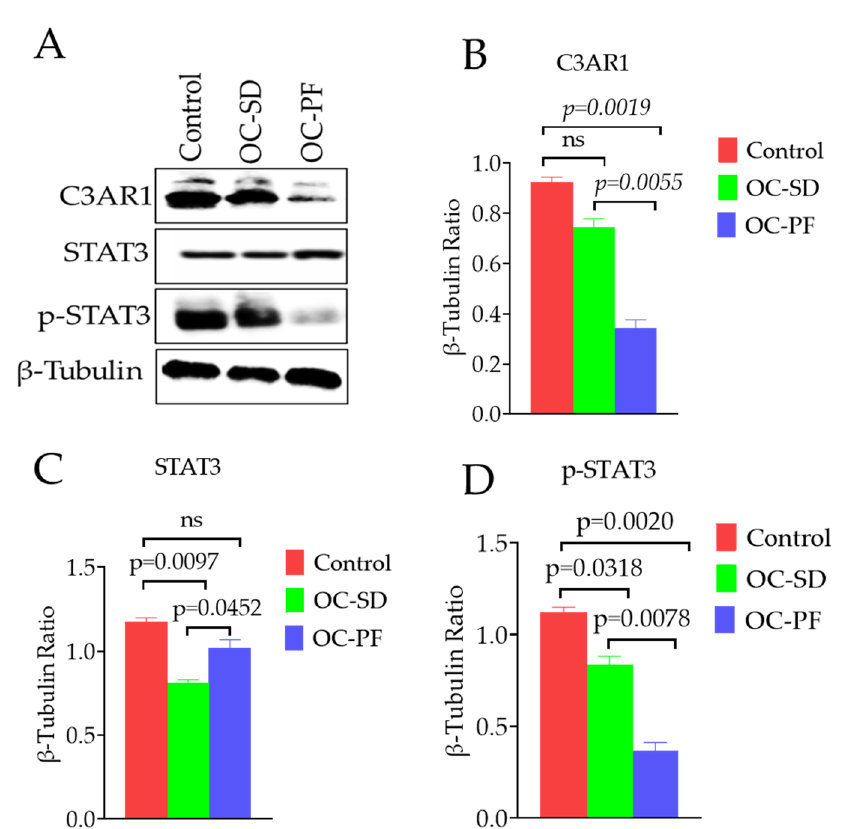
Figure 7. OC-PF and OC-SD treatment effects on the expression level of C3AR1, total and activated downstream target STAT3 in 5xFAD mouse brains. ( A ) Western blot showing the OC-PF and OC-SD treatments effect on the expression level of C3AR1, STAT3, and p-STAT3 in 5xFAD brain homogenates. ( B – D ) Scanning densitometric analysis of the blot for C3AR1 (F (2, 6) = 93.70, p < 0.05, STAT3 (F (2, 6) = 29.05, p < 0.05), and p-STAT3 (F (2, 6) = 88.00, p < 0.05), respectively. Scanning densitometry was executed for each blot, conducted in triplicate and the integrated optical density of each band was normalized with the corresponding density found for β -tubulin in the same blot. Data are presented as mean ± SEM. Statistical analysis was determined by one-way analysis of variance (ANOVA) followed by post-hoc analysis by Tukey’s test; p < 0.05 was considered